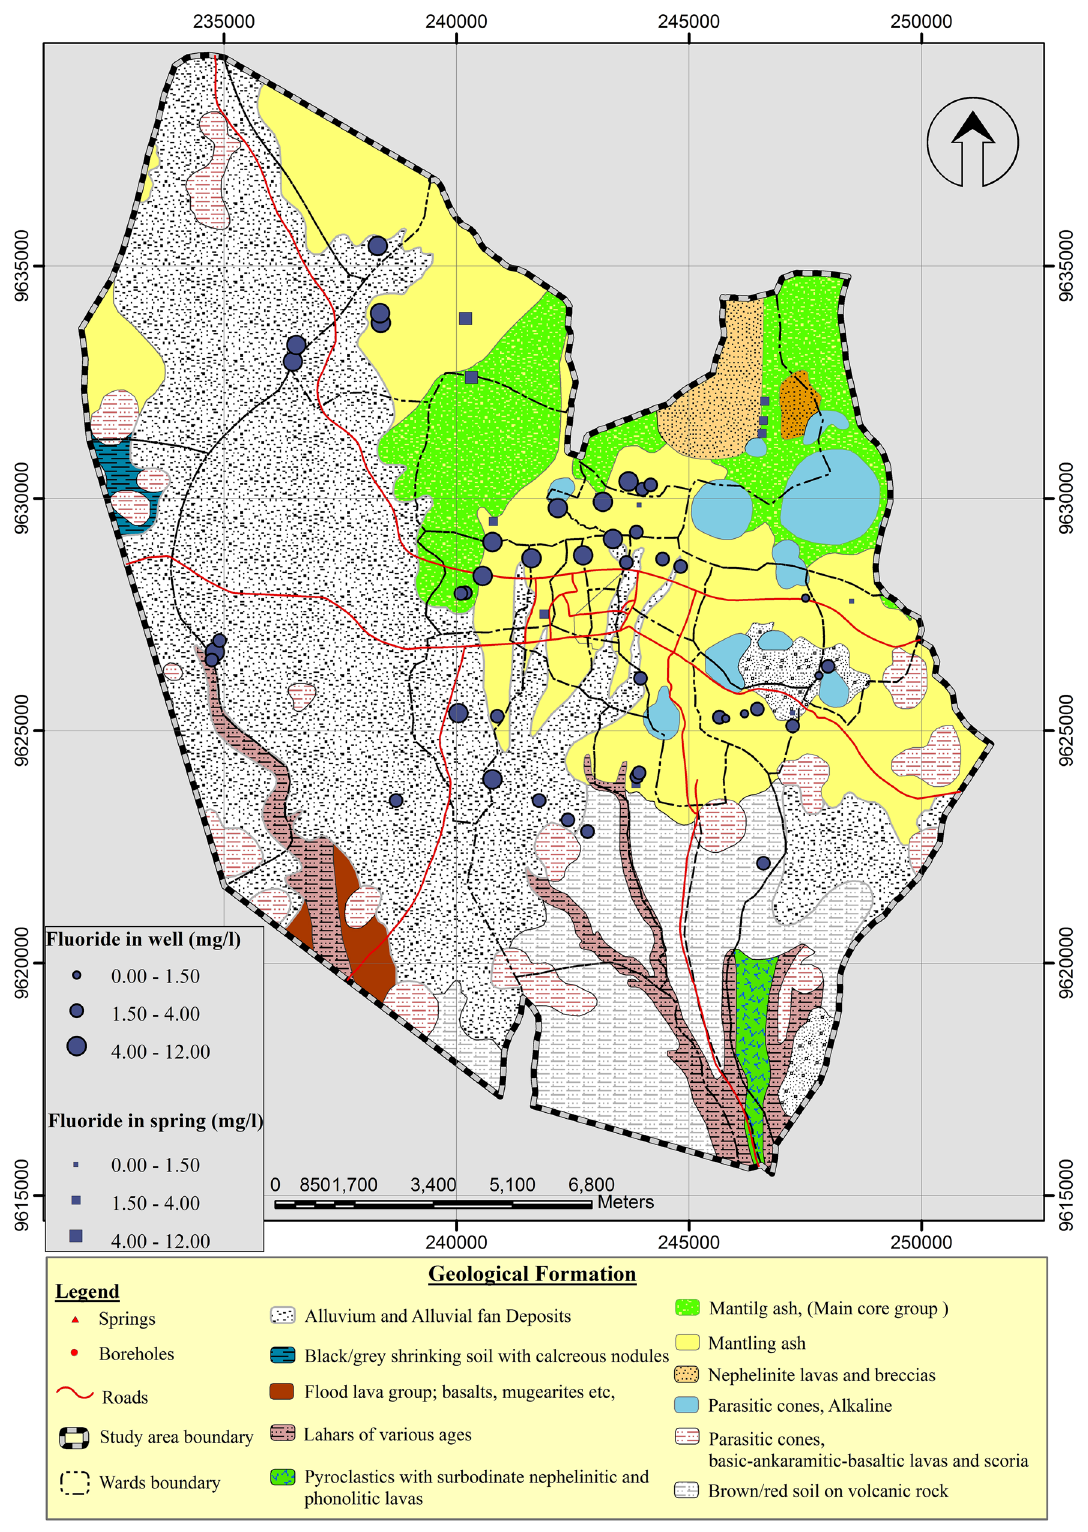
Fig. 11 Fluoride spatial distribution map for spring and well